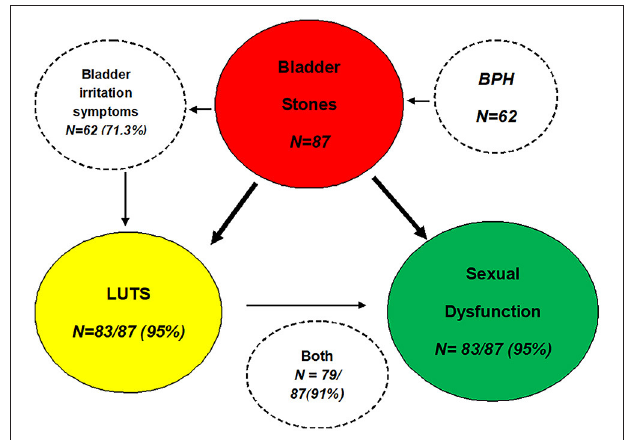
FIGURE 2 | Diagram showing the relationship between sexual dysfunction, bladder stones, and LUTS in the study population.